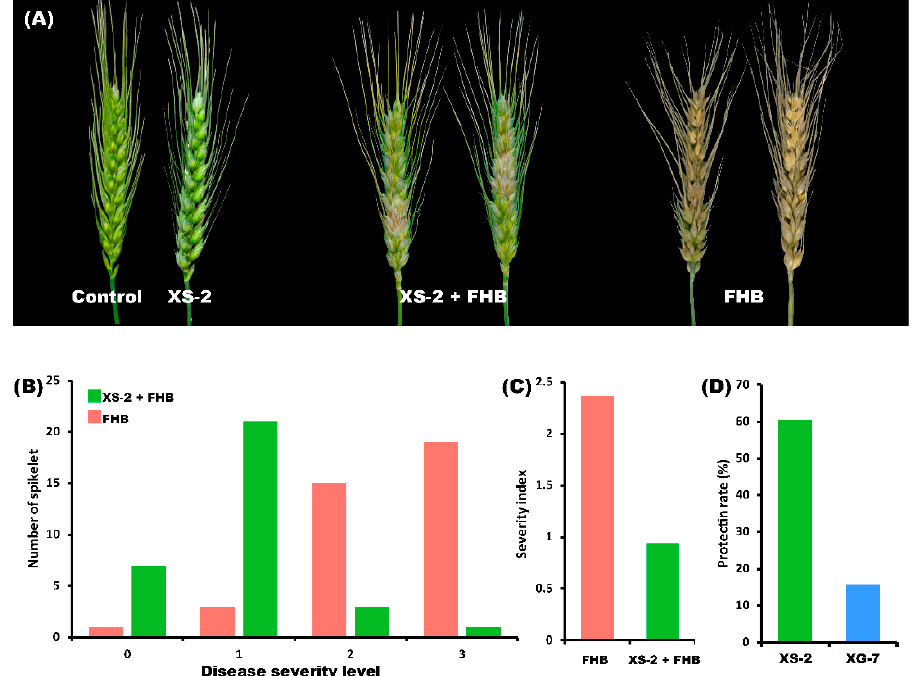
Figure 4. Antagonistic in vitro test of XS-2 against F. graminearum on wheat heads. ( A ) Symptoms of wheat heads inoculated with XS-2, FHB (Fusarium Head Blight, F. graminearum ), and XS-2 plus FHB, distilled water was used as a control. ( B ) Number of spikelets showing different disease severity levels. ( C ) The severity index of wheat heads inoculated with XS-2 plus FHB and of wheat heads inoculated with FHB alone. ( D ) The protection rate of XS-2 compared to XG-7. XG-7 is another endophyte isolated in this study, including the antagonistic effect of which was second to XS-2 in dual culturing calculated using the following formula: (n 0 × 0 + n 1 × 1 + n 2 × 2 + n 3 × 3)/N, where n 0 , n 1 , n 2 , and n 3 represent the number of wheat heads exhibiting disease levels 0, 1, 2, and 3, respectively, and N formula: (SI FHB – SI (XS-2 + FHB) )/SI FHB × 100, where SI (XS-2 + FHB) and SI FHB represent the SI values of the XS-2